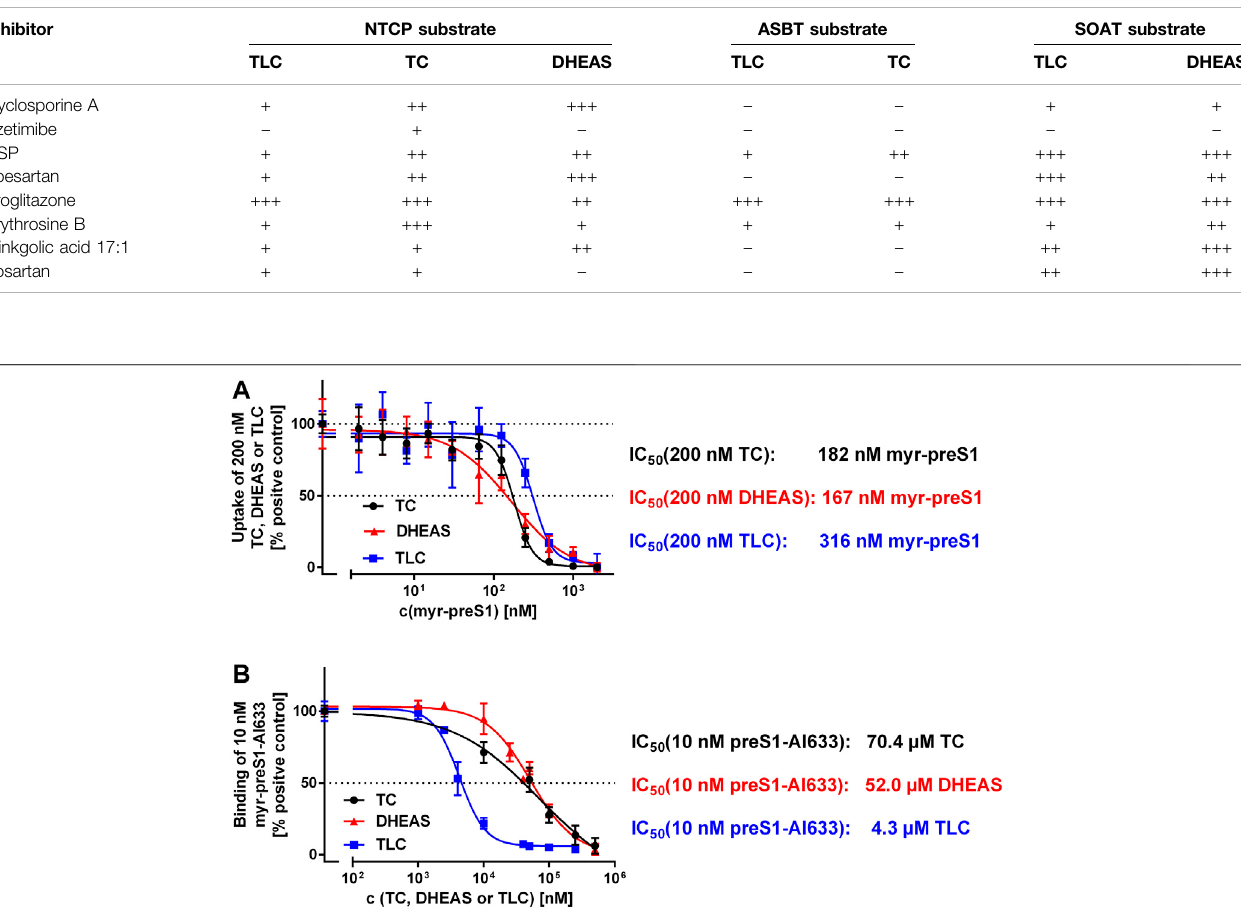
TABLE 5 | Inhibitor screening for NTCP, ASBT and SOAT. [ 3 H]TLC, [ 3 H]TC, and [ 3 H]DHEAS substrate uptake was analyzed in NTCP-HEK293, ASBT-HEK293, and SOAT- HEK293cellsinthepresenceoftheindicatedinhibitorsat100 µMinhibitoryconcentrations.Gradingofthenetuptakecomparedtothenon-inhibitedcontrolwas: “ − ” for 80 – 100%residualuptakeoftherespectivesubstratecompared topositivecontrol(w/oinhibitor), “ + ” for50 – 79%residualuptake(weakinhibition), “ ++ ” for20 – 49%residual uptake (medium inhibition) and “ +++ ” for 0 – 19% residual uptake (strong inhibition). Experiments were performed in duplicate each with triplicate determinations ( n (cid:1) 6).